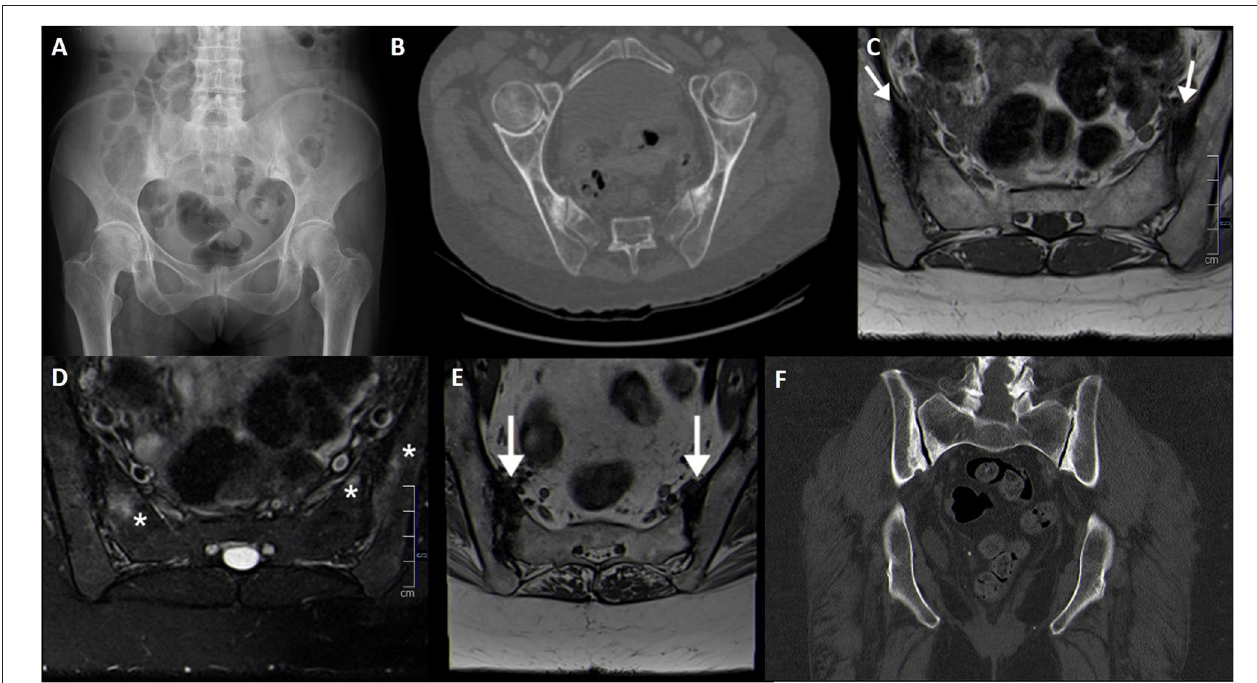
FIGURE 6 | Fifty seven-year-old female patient with bilateral osteitis condensans ilii evident on pelvis radiography (A) and CT (B) . Another patient, with post-partum bilateral bone marrow edema of the sacroiliac joint and sclerotic changes compatible with osteitis condensans ilii (arrows, asterisks), shown on MRI sequences (C–E) and CT (F) .